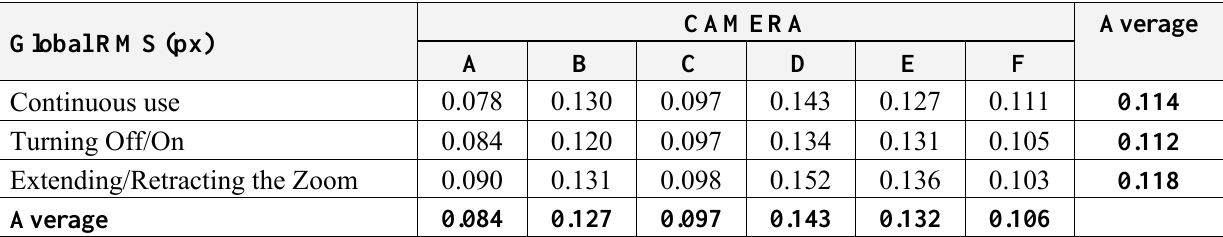
Table 8. Global marking residuals (in pixels) obtained in the 372 calibrations performed in all six cameras analyzed.